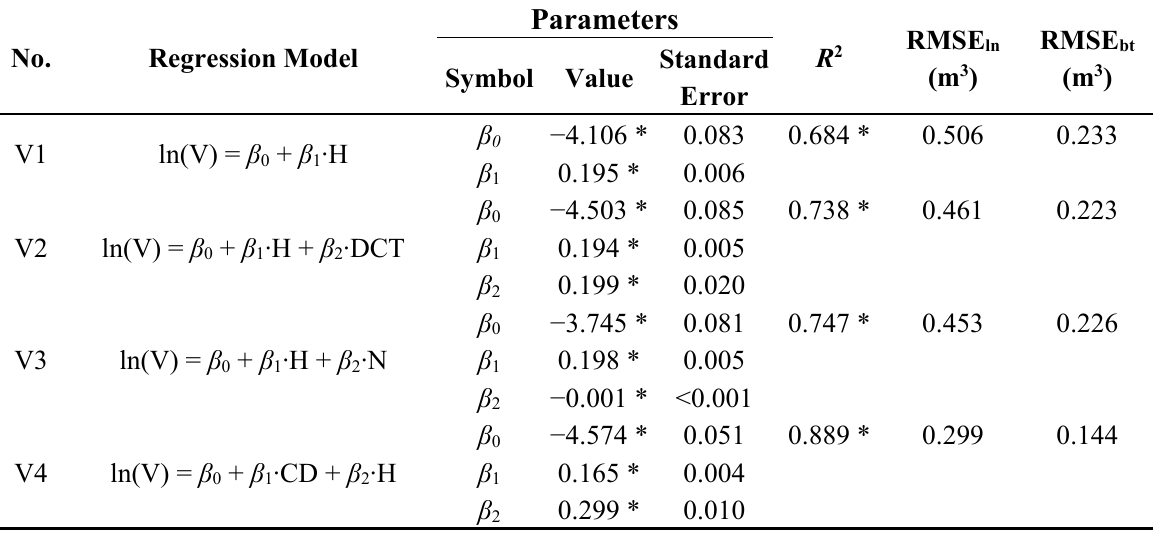
Table 4. Description and evaluation statistics for four selected black pine merchantable tree volume (V)